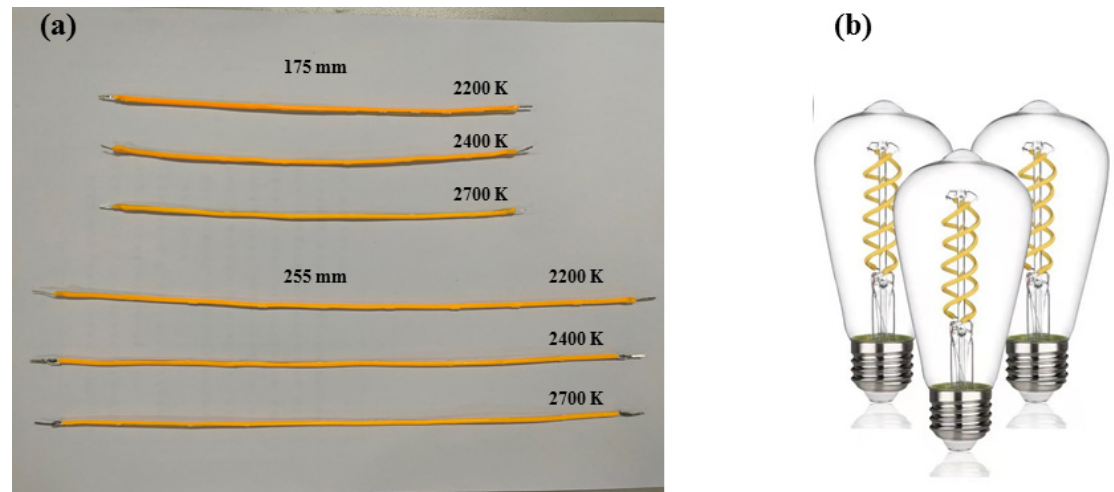
Figure 1. ( a ) Two filaments with different lengths (175 mm and 255 mm) under three color temperatures (2200 K, 2400 K, 2700 K); ( b ) LED filament bulb.